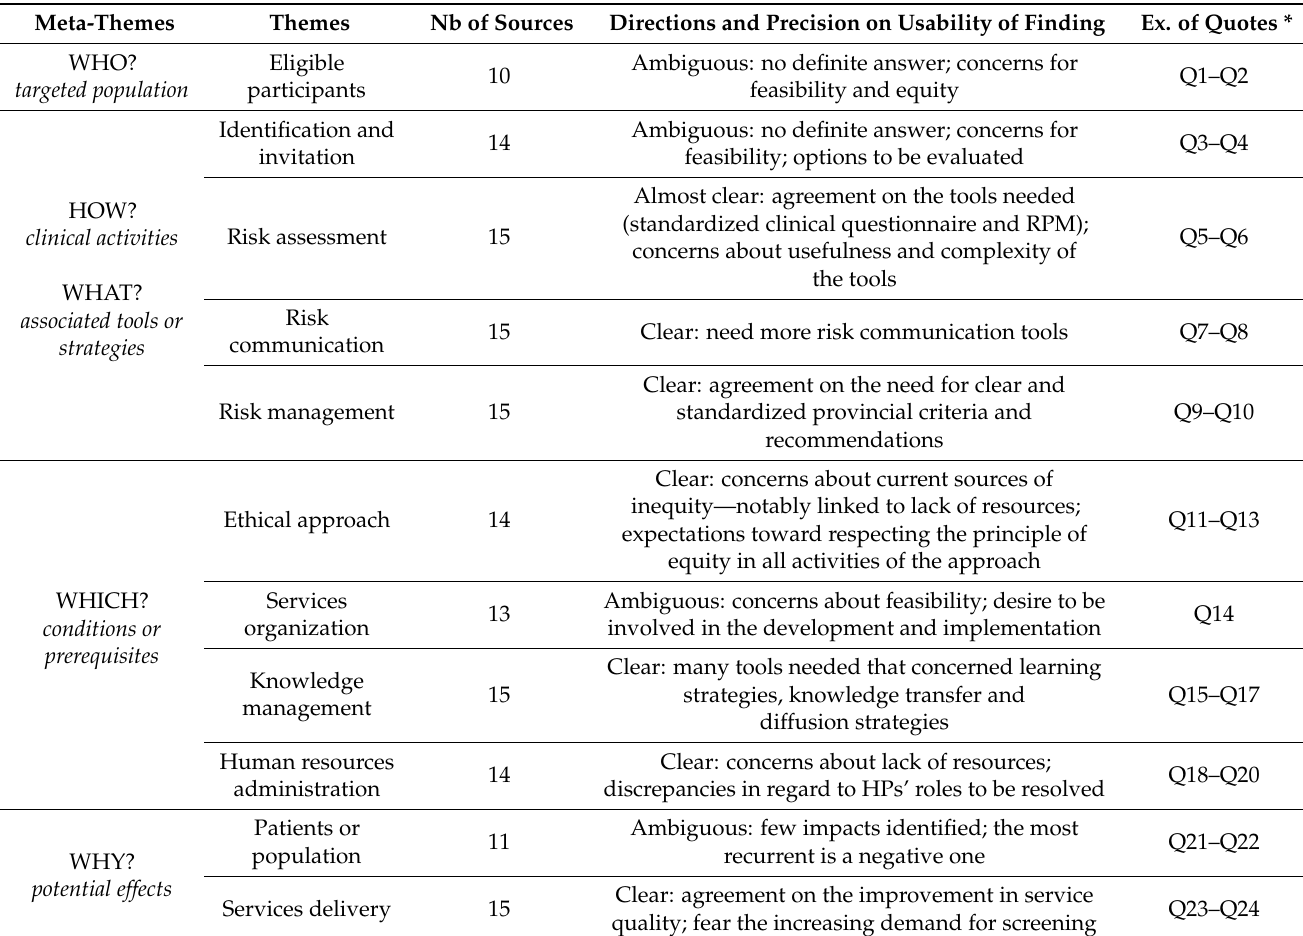
Table 3. Main themes, by logical model components, and their degree of